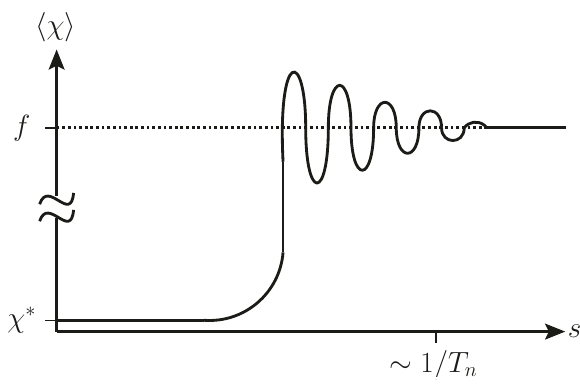
Figure 1 . A typical wall profile found in close-to-conformal potentials. After nucleating by tun- neling to the exit point, χ ∗ (cid:28) f , the field rolls down and undergoes damped oscillations around the minimum of its potential. The typical wall thickness is L